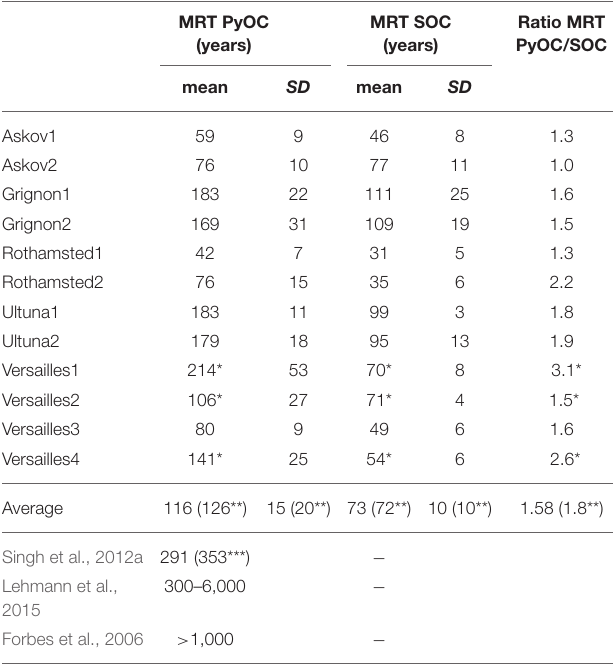
TABLE 3 | Mean residence time (in years) for PyOC and SOC calculated from the whole data set and estimates from previous